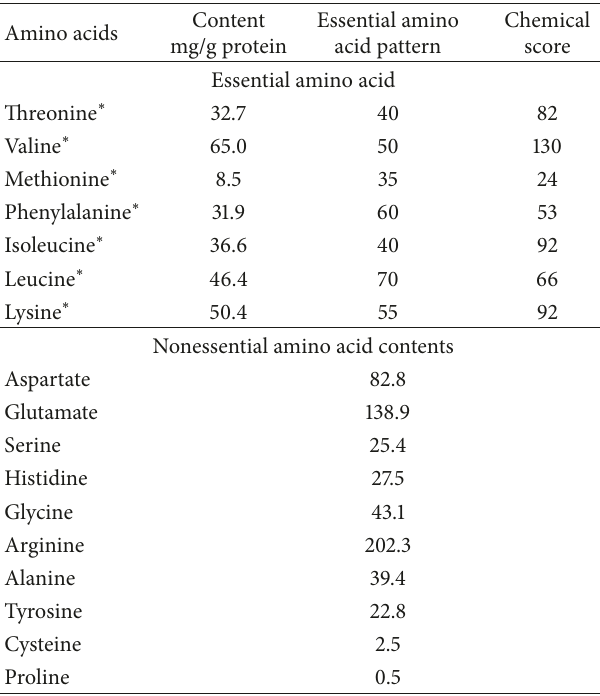
Table 2: Amino acid composition of yellow maca cultivated in